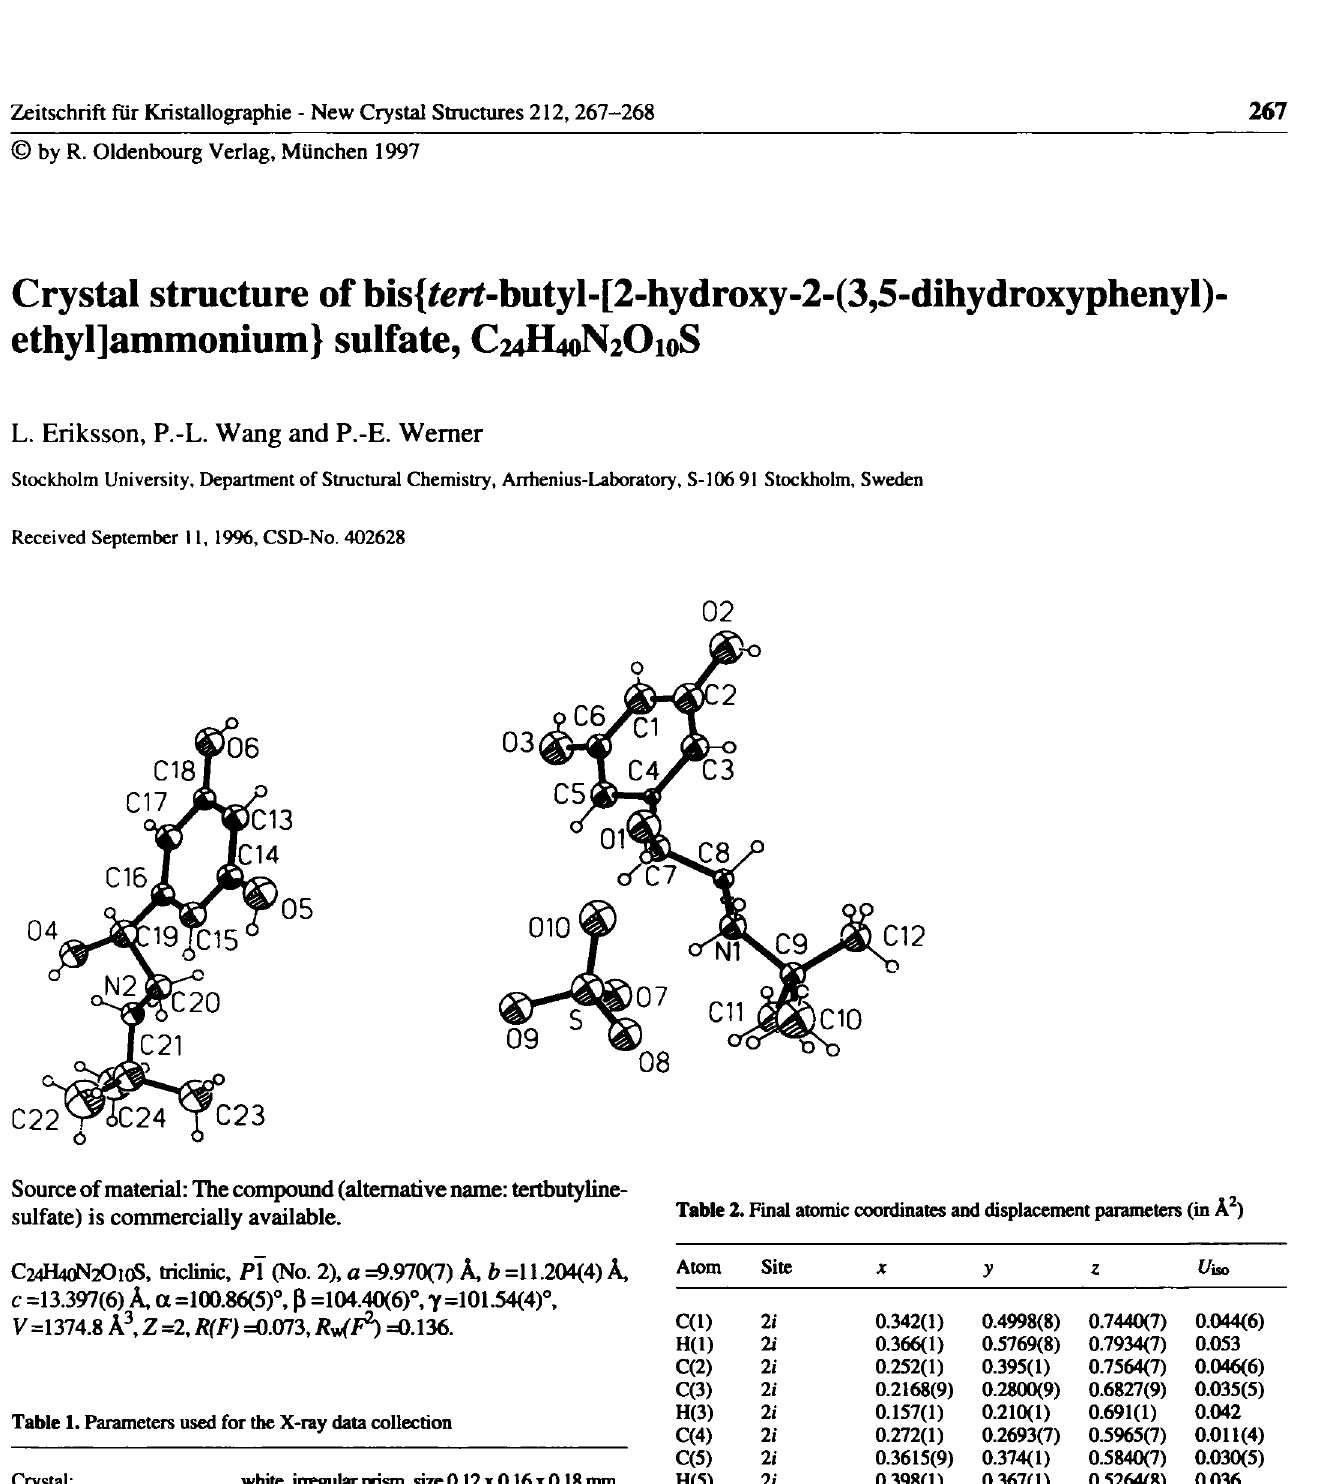
Table 1. Parameters used for the X-rav data